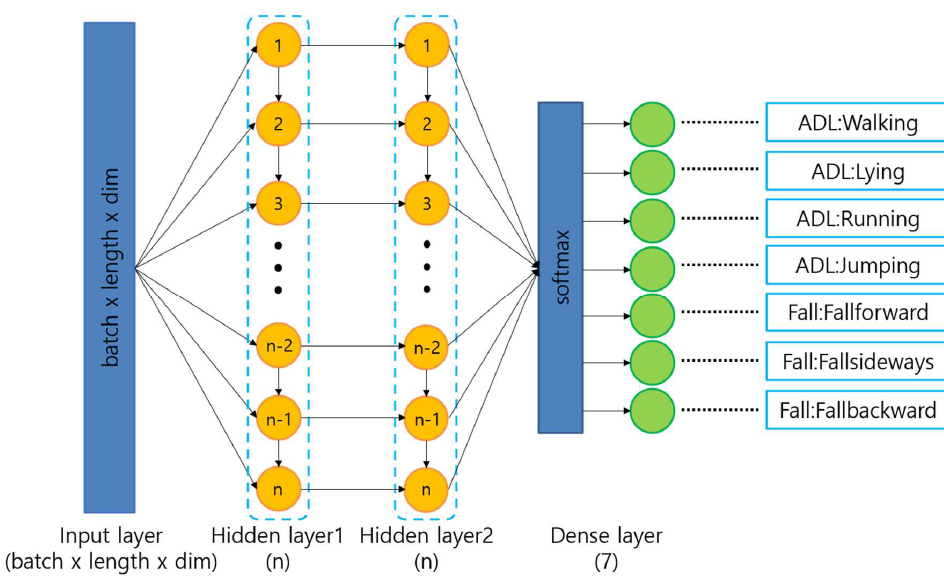
Figure 5. Fall detection model architecture for LSTM.